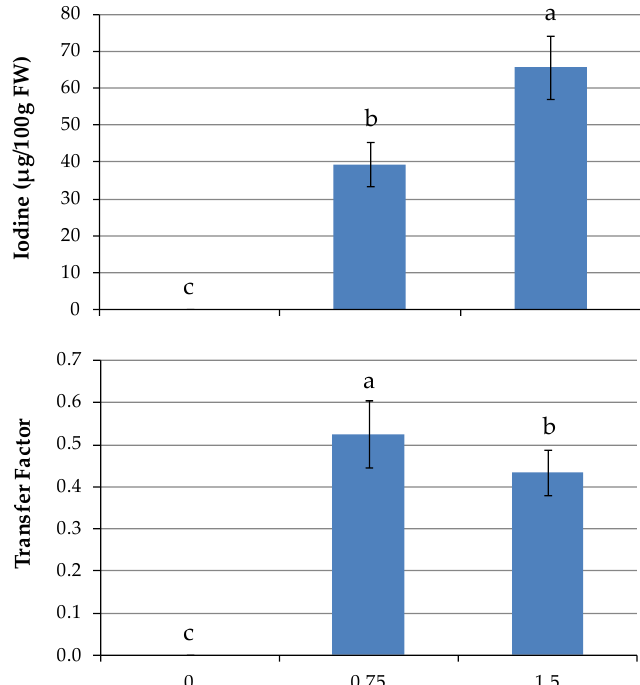
Figure 4. Effect of I rates in the nutrient solution on vegetable’s I content and TF at 2nd harvest ( p ≤ 0.05). For I level 0 mg/L, values are lower than the quantification limit. Different letters indicate significant differences at α = 0.05 by LSD test. Table 3. Color parameters of raw leaves in Brassica genotypes supplied with different levels of I in the NS.